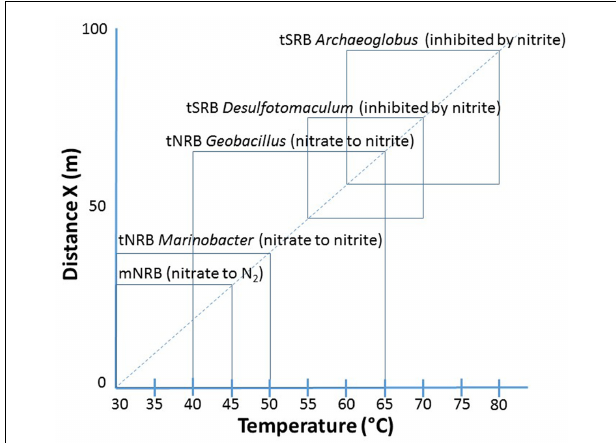
FIGURE 9 | Distribution of NRB and SRB from Terra Nova identified or cultivated in this study in the NIWR. These included mesophilic NRB, tNRB Marinobacter , tNRB Geobacillus , tSRB Desulfotomaculum and the thermophilic sulfate-reducing archaeon (tSRA) Archaeoglobus . The latter was not cultivated and its range of activity was inferred from the literature. The scale on the Y axis is an estimate of the size of the NIWR (from 0 to 100